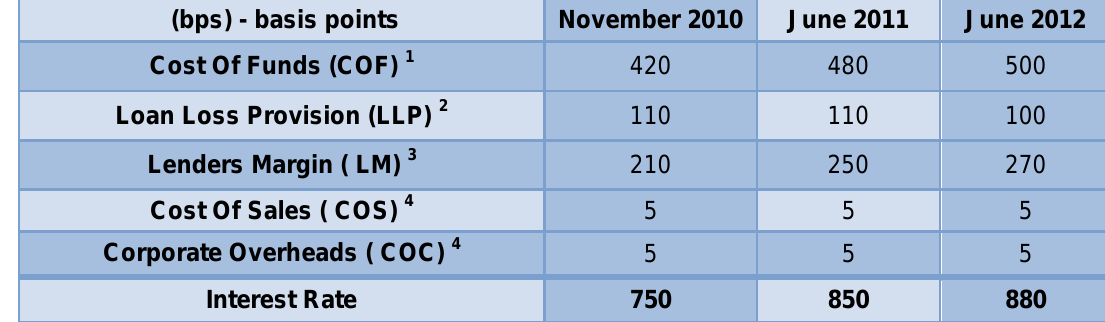
Table 2: Possible Future Changes in Typical Mortgage Lending Interest Rate